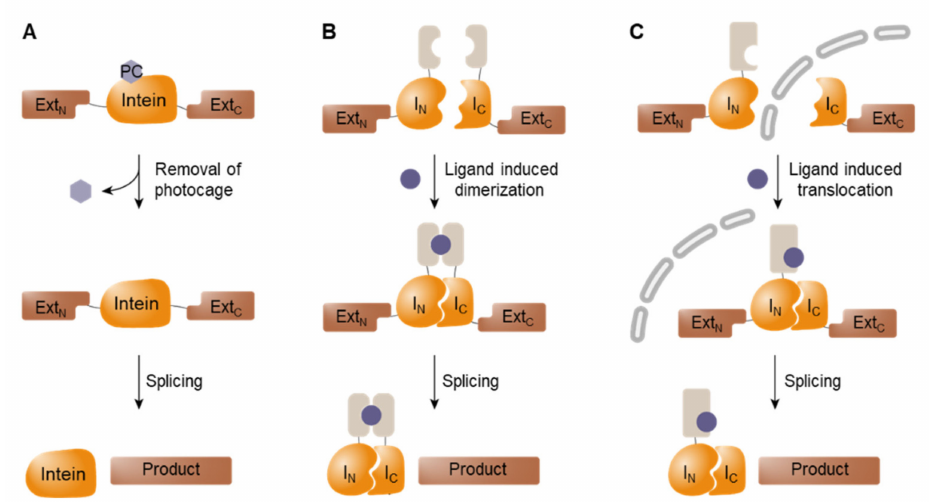
Figure 3. Conditional protein splicing. ( A ) The photocage can be removed by light stimuli to activate intein-mediated reaction. ( B ) Low-affinity split intein pairs are activated by induced dimeriza- tion. ( C ) Spatially separated split inteins are activated by translocating molecules into the same cellular